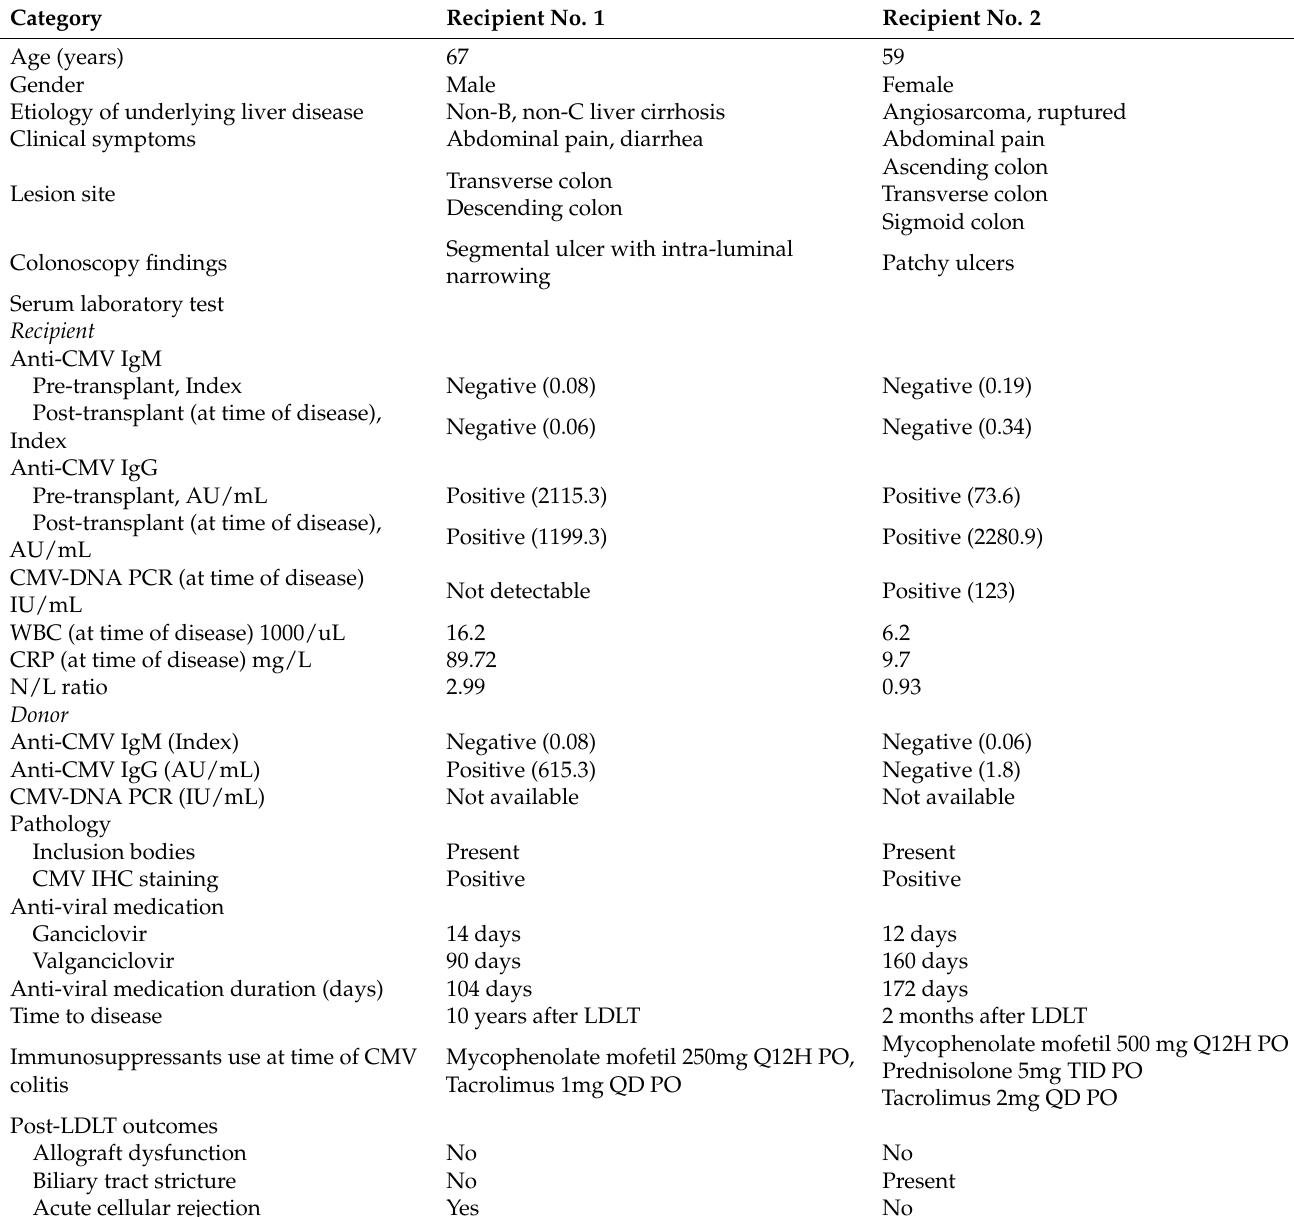
Table 4. Profiles of the 2 recipients with biopsy-proven CMV colitis after living donor liver transplan-